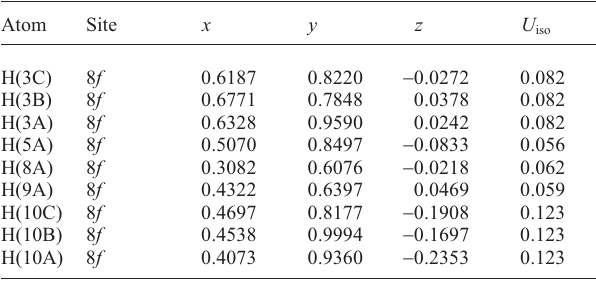
Table 2. Atomic coordinates and displacement parameters (in Å 2 )